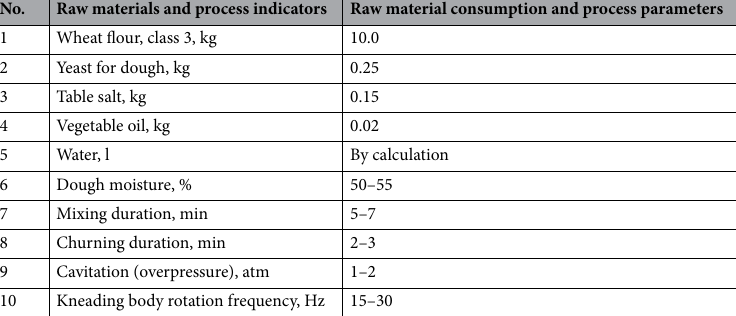
Table 6. Recipe and dough cooking modes for whipped yeast bread made from grade 3 flour.